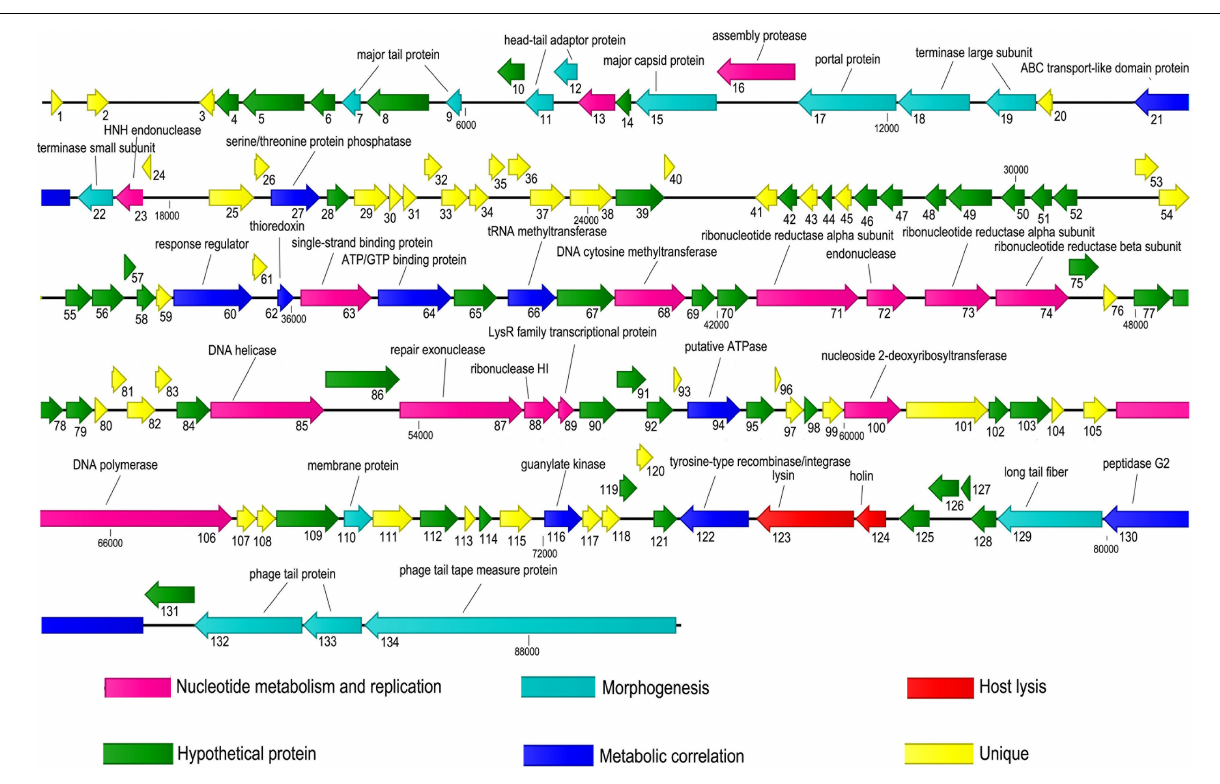
FIGURE 3 | Gene module map of JF1. Each arrow represents an open reading frame (ORF), and the direction of the arrow represents the direction of gene transcription. The predicted functional proteins were divided into six modules according to their functions. All modules are represented in different colors, and the putative functions and names of the genes are listed